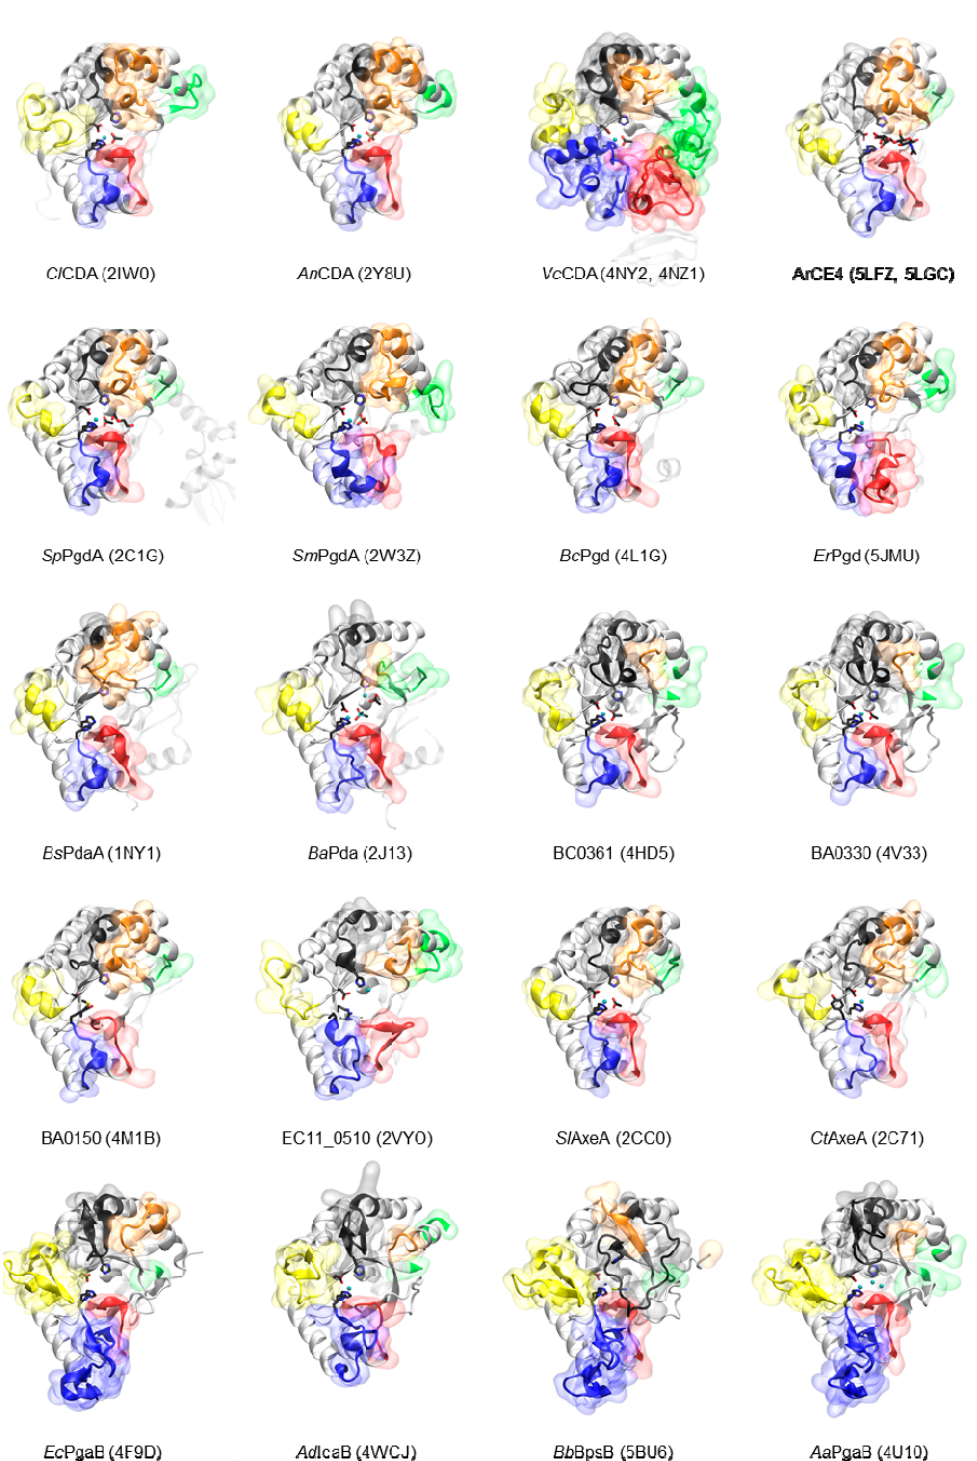
Figure 3. Three-dimensional structures by X-ray crystallography of the CE4 enzymes listed in Table 1. The Vp CDA structure (3WX7) is essentially identical to that of Vc CDA. Loops are colored as in Figure 4.